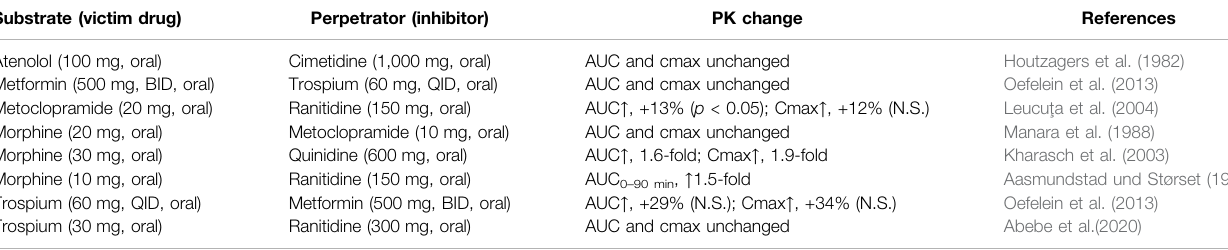
TABLE 4 | Overview of clinical drug-drug interactions which may allow conclusions on intestinal OCT1.